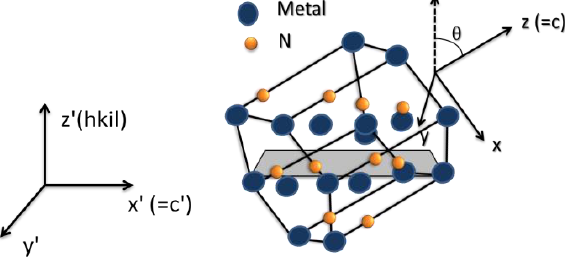
Figure 4. Configuration of the two coordinate systems (x,y,z) and (x’,y’,z’) used to describe non-c-plane QW growth. The shaded area denotes (hkil) orientation.